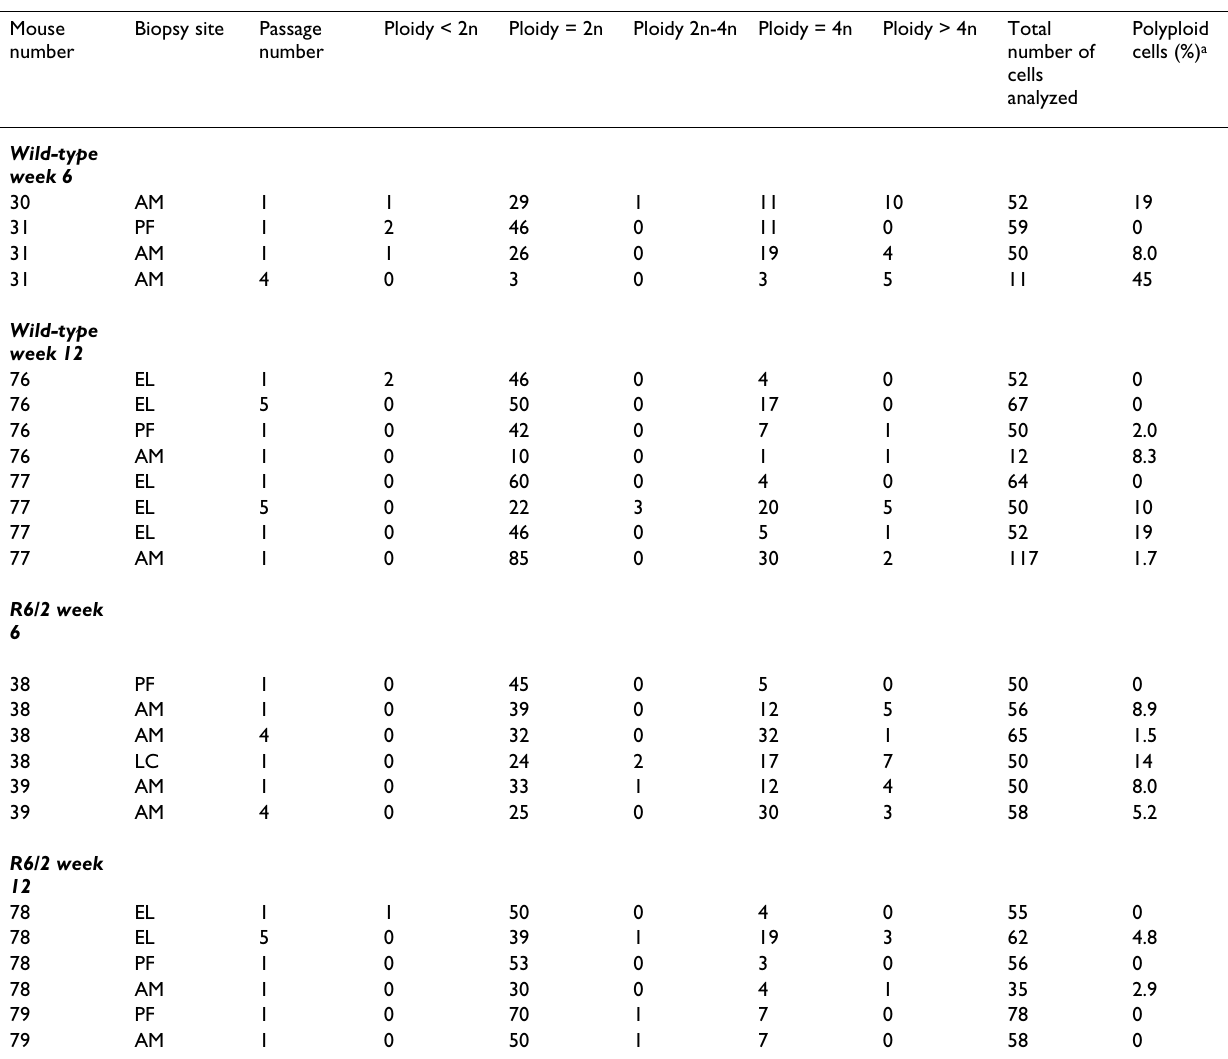
Table 1: Cytogenetic